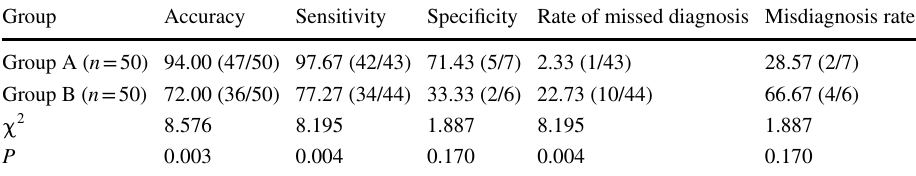
Table 4 Comparison of